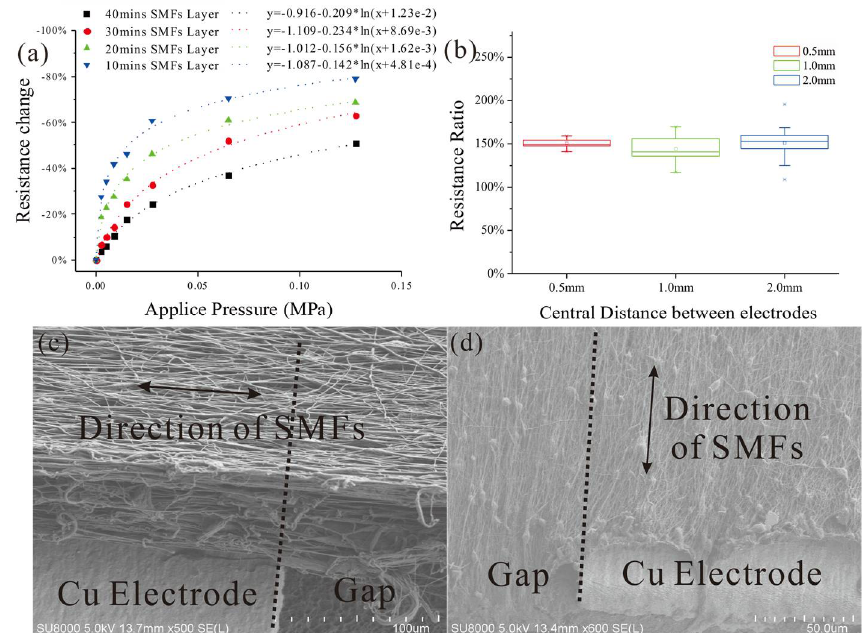
Figure 8. ( a ) The resistance change of SE with different thickness of SMFs layer under applied weight (measured in 10~15 s after weight placed); ( b ) The resistance change ratio comparison between SMFs perpendicular and parallel to electrodes with different CDoE; ( c ) SEM image of SMFs perpendicular to electrodes; ( d ) SEM image of SMFs parallel to electrodes.